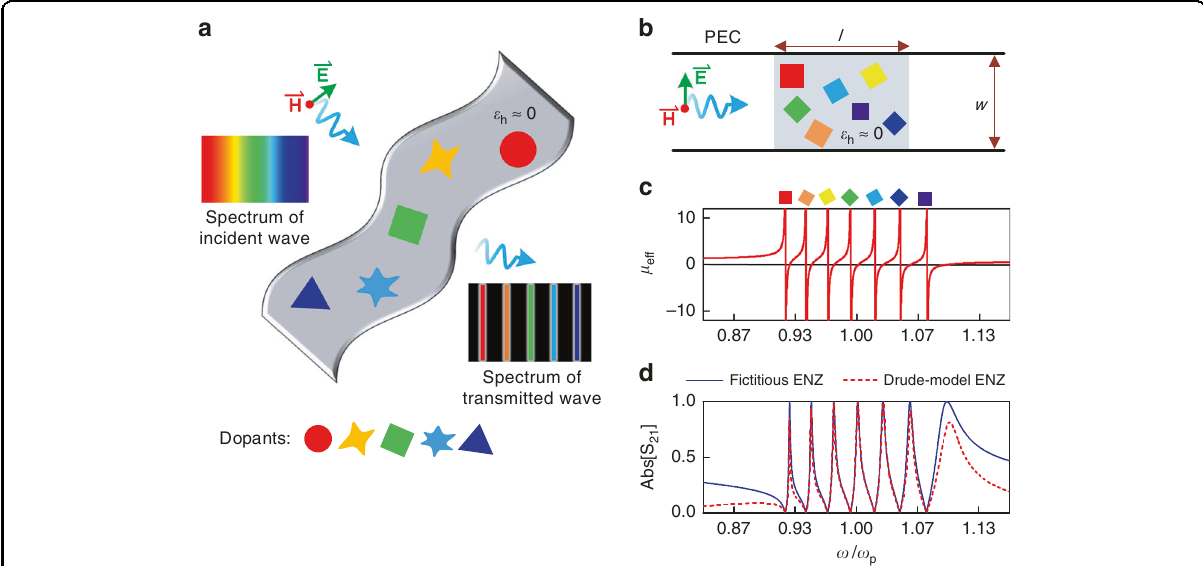
Fig. 1 Multiple dopants in ENZ medium as noninteracting resonators. a Conceptual sketch of a two-dimensional (2D) ENZ host with a relative permittivity ε h ≈ 0 containing multiple arbitrarily-located dielectric rods as “ dopants ” , which act as noninteracting resonators fi ltering the light at their individual resonant frequencies. b Schematic plot of the two-dimensional (2D) ENZ medium in which seven dopants with square cross sections are embedded. Geometry parameters l and w are λ p and 0.8 λ p, respectively, where λ p is the free-space wavelength at ω p = 2 π × 3 × 10 9 rad/s. The dopants are chosen with a relative permittivity ε d of 37 and slightly different side lengths. The incident wave is TM-polarized with a magnetic fi eld along the out-of-the-plane axis. c Calculated relative effective permeability and ( d ) transmission amplitude for the seven-dopant con fi guration in ( b ) under conditions of fi ctitious nondispersive ENZ and Drude-dispersive ENZ